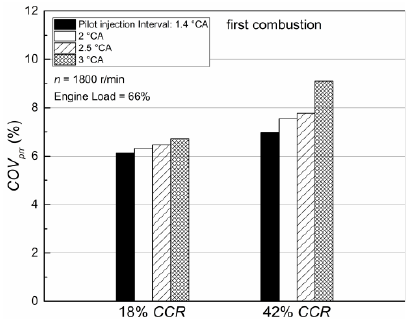
Figure 11. COV PRR of first combustion stage under different pilot injection periods.